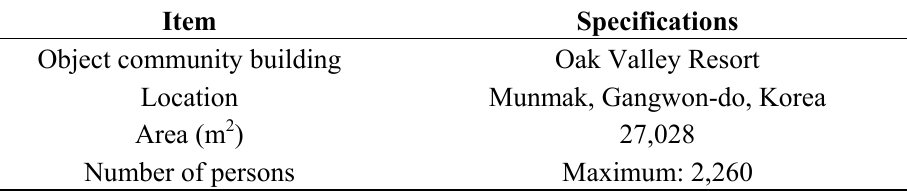
Table 1. Specifications of the object community building.